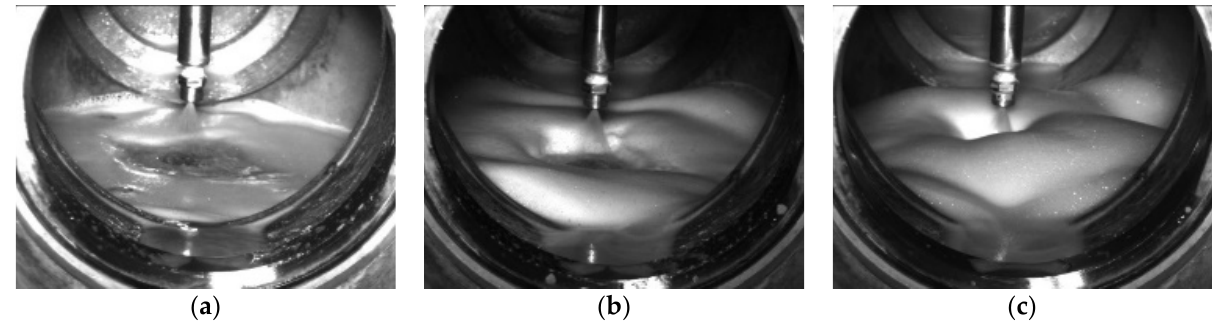
Figure 21. The steady-state heat transfer coefficients of spray cooling at different ethanol concentra- tions.